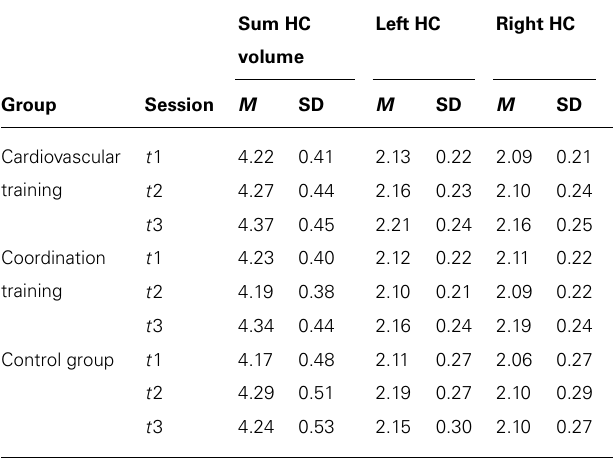
Table 6 | Mean (M) and Standard deviation (SD) for hippocampal volume in cm 3 collapsed over both hemispheres (sum HC: sum of left and right volume) and separately for left (left HC volume) and right hemisphere (right HC volume) for all three measurement time points ( t 1, t 2, t